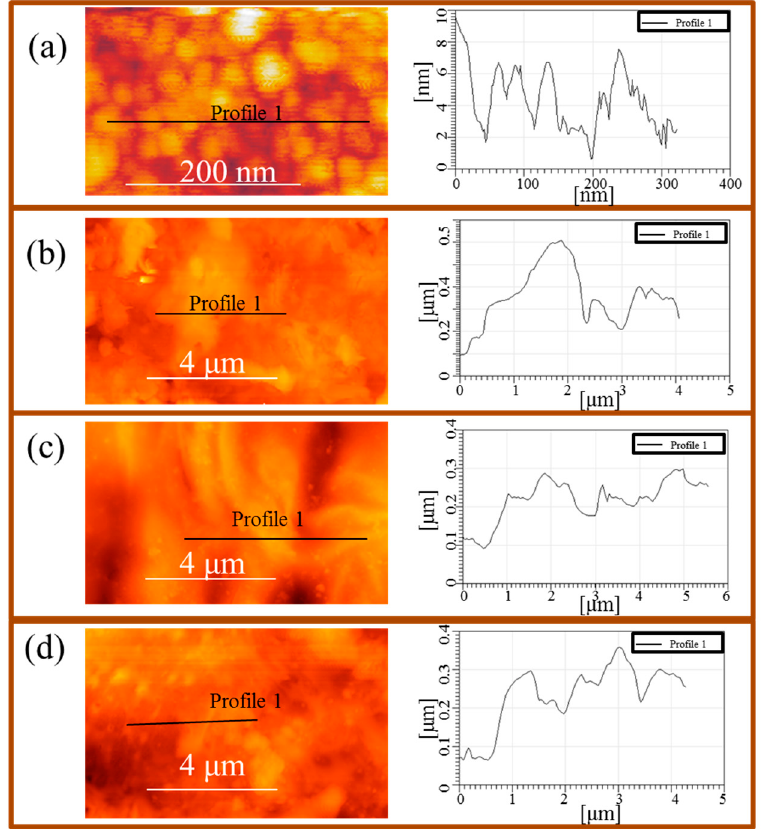
Figure 1. ( a ) Atomic force microscopy (AFM) images with height profiles of the copper nanoparticles (CuNPs)-Fe surface before corrosion; ( b ) corroded CuNPs-Fe surface (after 24 h of exposure to 0.5 M HCl); ( c ) corroded CuNPs-Fe surface with presence of Thr (10 − 1 M); ( d ) corroded CuNPs-Fe surface with presence of Thr (10 − 3 M).